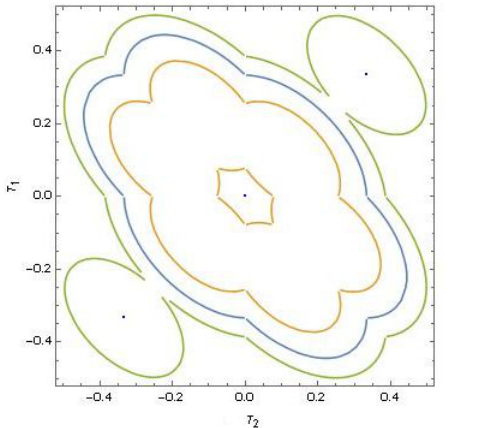
Figure 4 . Contours of L h ( x 1 = (cid:6) 1 = 4 ; r k = 2 = 3; T k ). The blue curve and dots correspond to zero value, inside the blue curve except at the origin corresponds to positive values, while outside the blue curve and away from the blue dots corresponds to negative